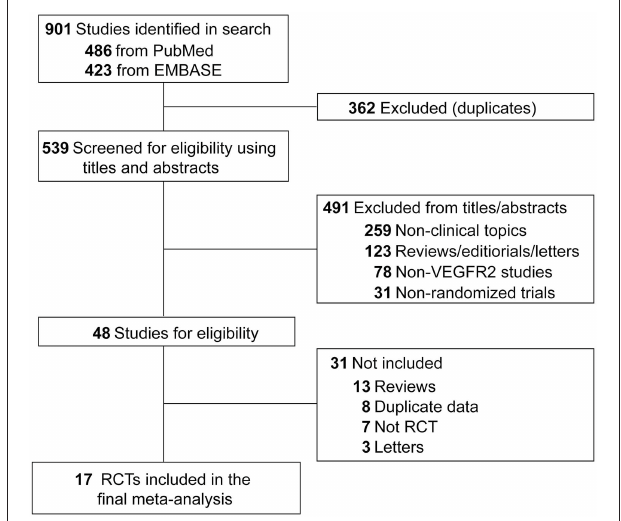
FIGURE 1 | Flow-chart of eligible trials included in this